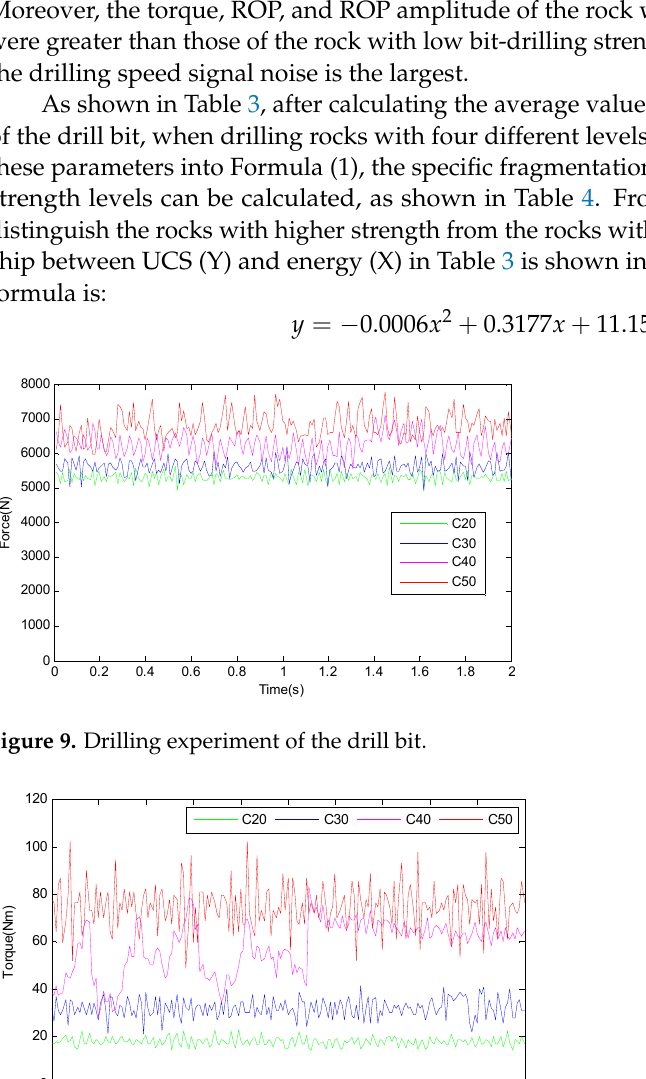
Figure 10. Torque diagram of bit drilling in the rock experiment. Figure 11. Speed chart of the rock drilling experiment.